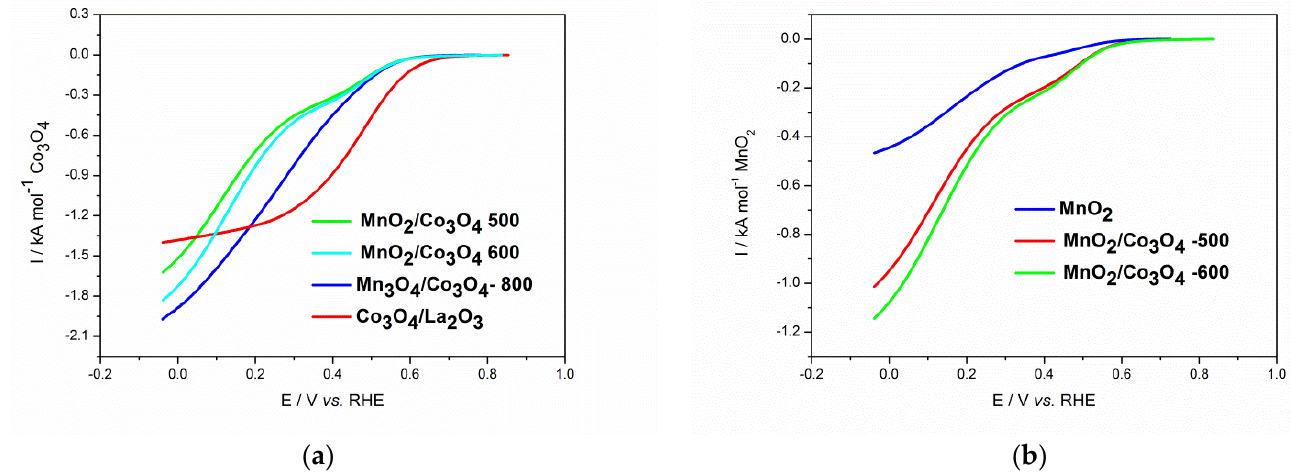
Figure 9. Comparison of all materials ( a ) per mol of Co oxide and ( b ) per mol of Mn oxide.